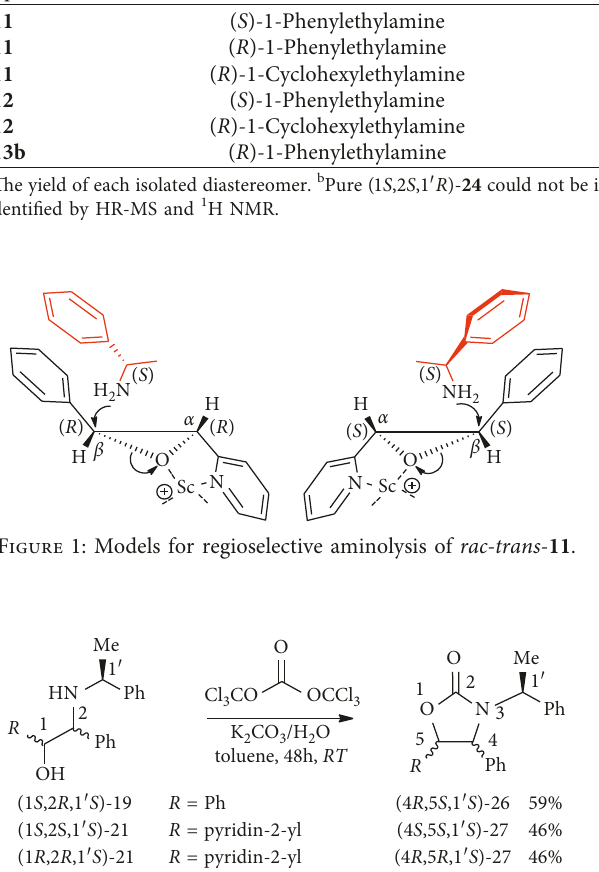
Scheme 5: Synthesis of oxazolidinones from β -amino alcohols.